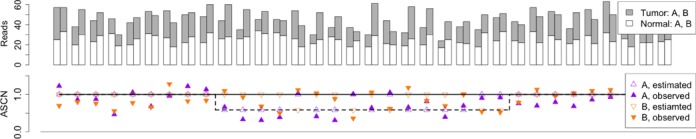
Observed allele-specific coverage at 34 loci in an example region containing an estimated 0.41-fold deletion of one parental chromosome. Top panel shows the allele-specific coverages in tumor (gray) and normal (white). Each grouped barplot corresponds to one loci location, with reads of the A allele on the left and reads of the B allele on the right. Bottom panel shows the estimated parental copy numbers of the two inherited chromosomes (in bold and dashed lines) for the tumor relative to matched normal. Empty triangles show the estimated ASCNs from falcon for the 34 loci in the region. Solid triangles show the observed ASCNs computed by Equation (6).